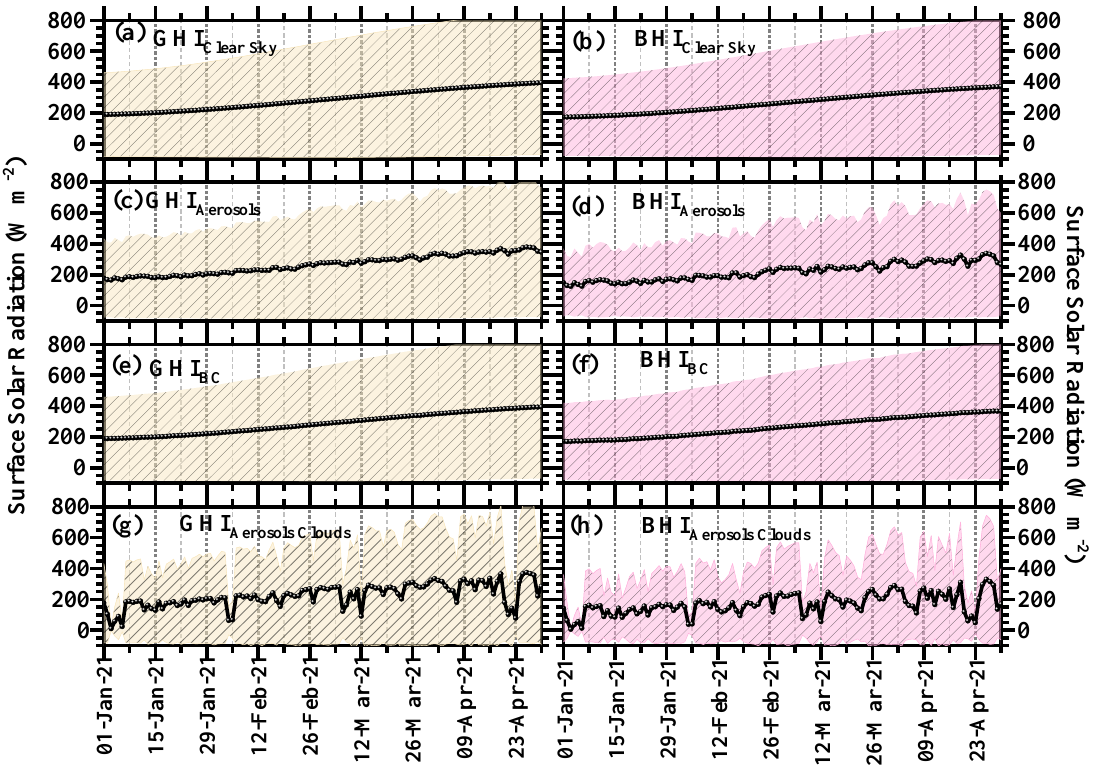
Figure 13. Time-series plots of GHI Clear Sky ( a ), BHI Clear Sky ( b ), GHI Aerosols ( c ), BHI Aerosols ( d ), GHI BC ( e ), BHI BC ( f ), GHI Aerosols Clouds ( g ) and BHI Aerosols Clouds ( h ), during January to April 2021. The shaded color in each panels shows the ±1 Standard Deviations.